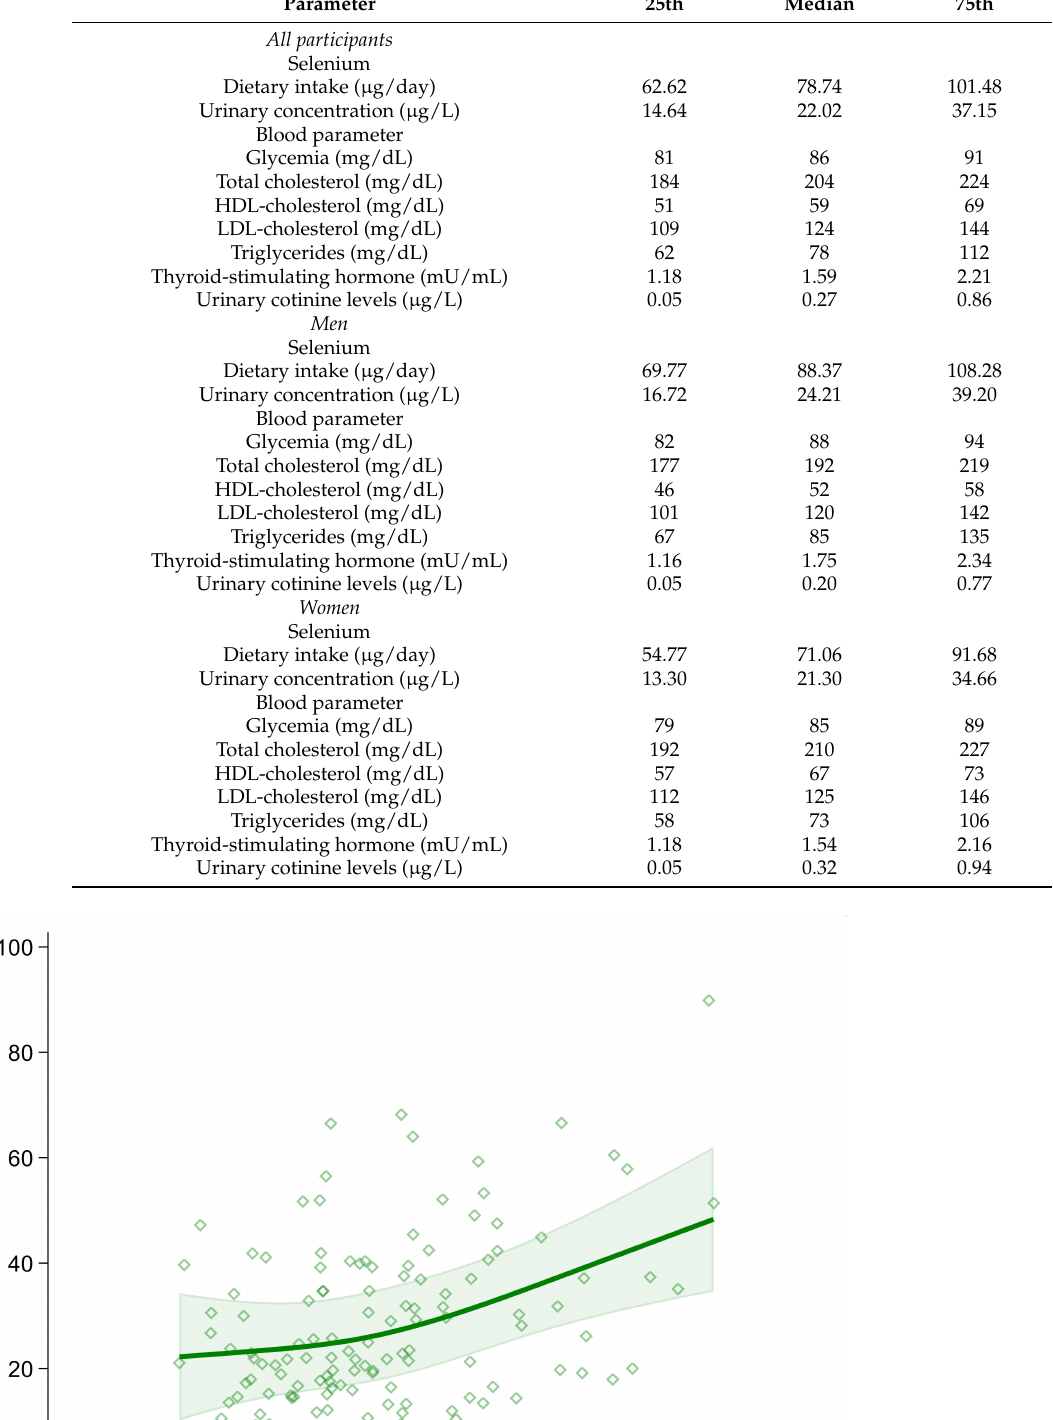
Table 2. Median, 25th and 75th percentile of urinary and dietary selenium distribution and fasting blood parameters in the study population ( n = 137).